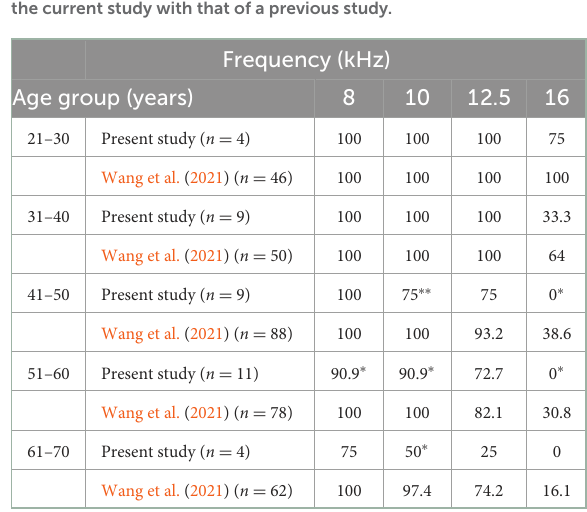
TABLE 3 A comparison of normalized percentage at 8–16kHz from the current study with that of a previous